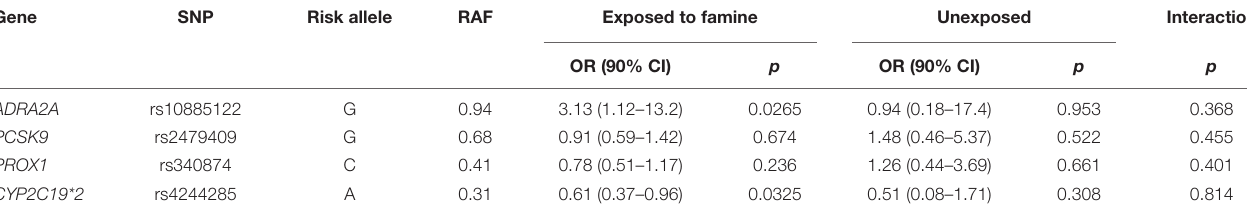
TABLE 2 | Genetic variants and the risk of ADVDR for offspring to parents exposed and unexposed to famine in the HKDR cohort. Gene SNP Risk allele RAF Exposed to famine Unexposed Interaction OR (90% CI) p OR (90% CI) p p ADRA2A